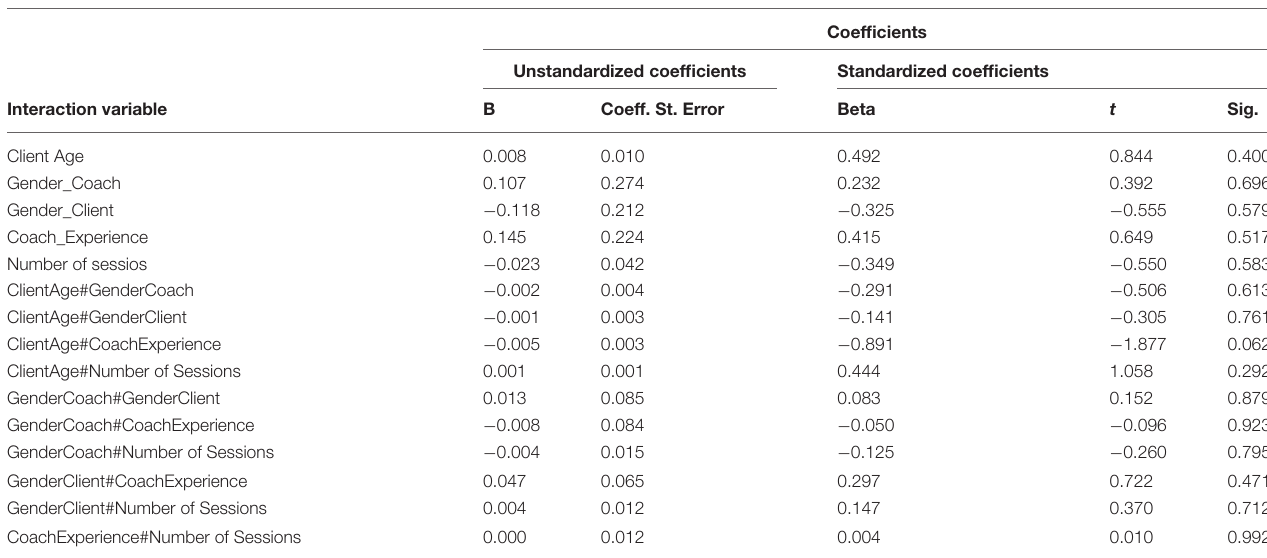
TABLE 5b | Quadratic curve type interactions. Quadratic curve type interactions with demographics and no of sessions